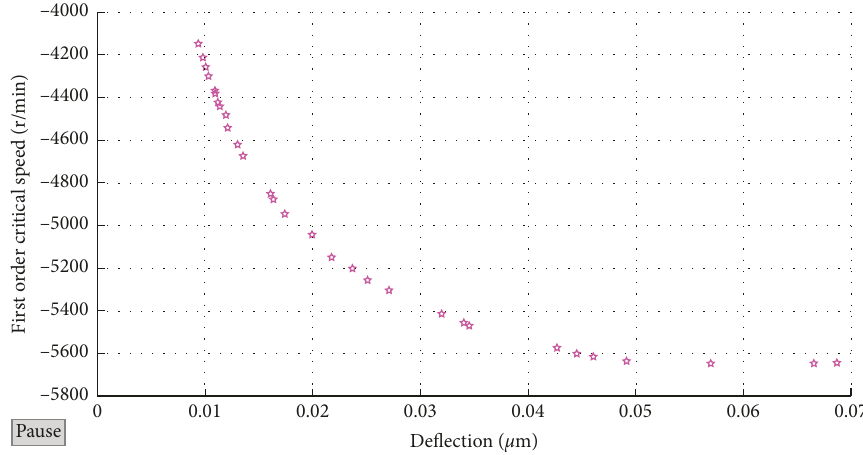
Figure 26: Pareto front end optimization of critical speed and deflection of the pump shaft. Table 13: Comparison of schemes before and after pump shaft optimization.